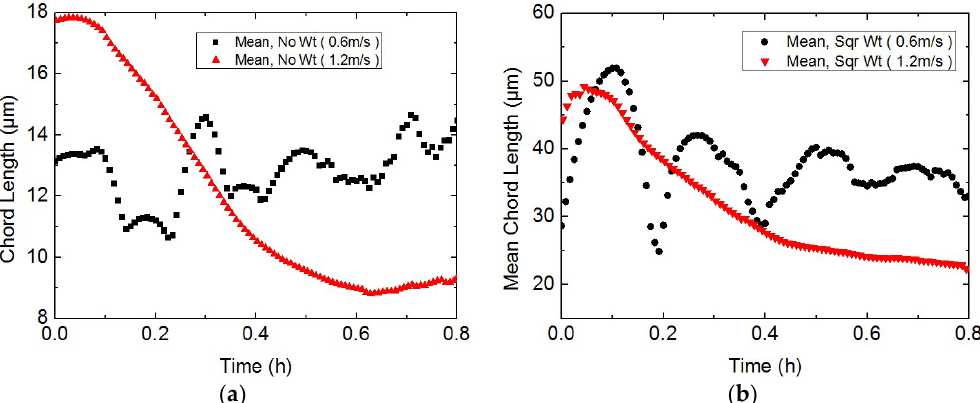
Figure 8. Influence of flow rate on mean chord length during the hydrate dissociation ( a , b ). ( a ) Influence of flow rate on mean chord length (8 MPa, 10% water-cut); ( b ) influence of flow rate on square-weighted chord (8 MPa, 10% water-cut).